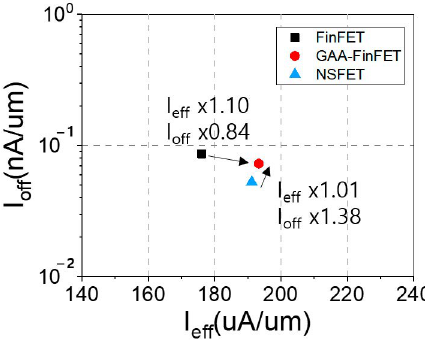
Figure 9. Off-state leakage current (I off ) versus effective drive current (I eff ) for FinFET and GAA- FinFET. Please note that the currents are normalized to the effective channel width.